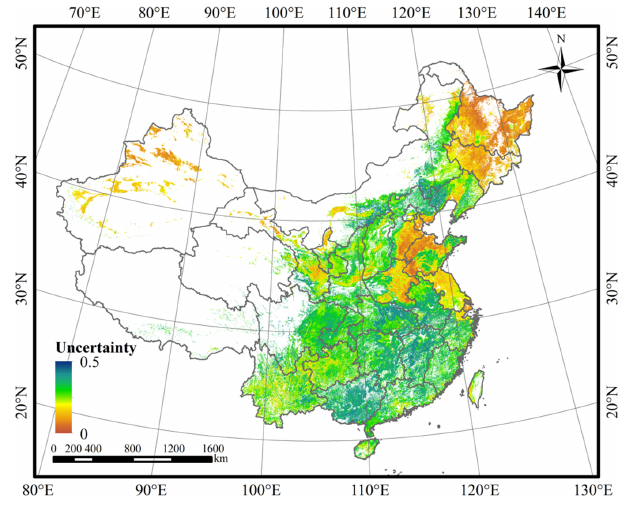
Figure 9. Pixel-level uncertainty of terrace mapping results. The uncertainty map was resampled to 1km × 1km spatial